Question: Write a descriptive caption for this figure.
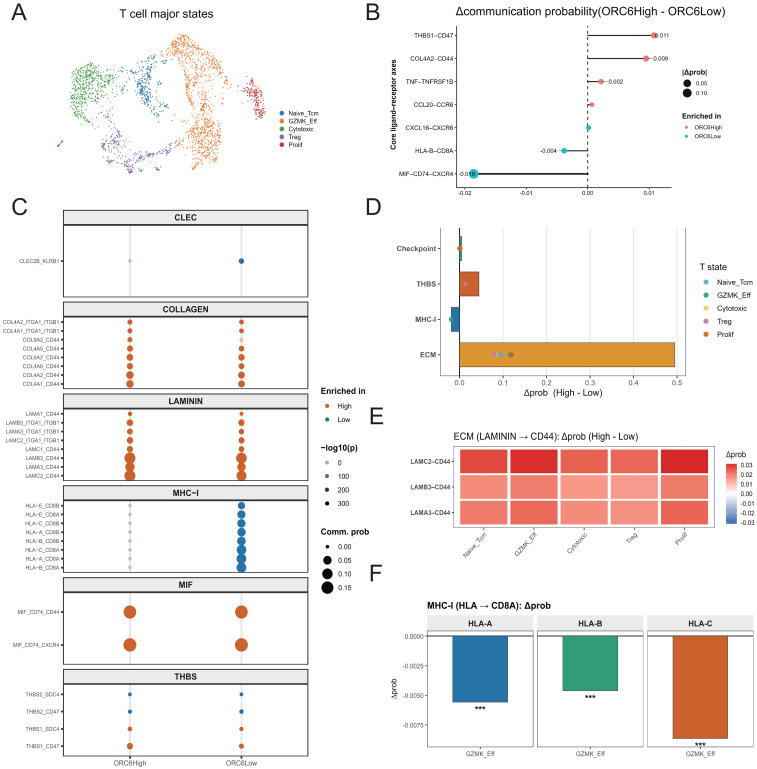
Answer: Transcript-based CellChat inference suggests hypothesis-generating epithelial–T-cell interaction patterns associated with the ORC6-high malignant epithelial state. (A) Overview of major T-cell states. (B) Representative ligand-receptor pairs showing differential communication strength between ORC6-high and ORC6-low conditions. (C) Pathway-level summary of differential interaction pairs across T-cell states. (D) Axis-level summary of the direction and magnitude of communication changes. (E) Δprob heatmap for a representative ECM-CD44 interaction axis across T-cell states. (F) Representative MHC-I-related interaction view (HLA-CD8). Δprob = prob(ORC6High) - prob(ORC6Low); Δprob > 0 indicates relative enrichment in ORC6-high, whereas Δprob< 0 indicates relative enrichment in ORC6-low. ***P < 0.001.